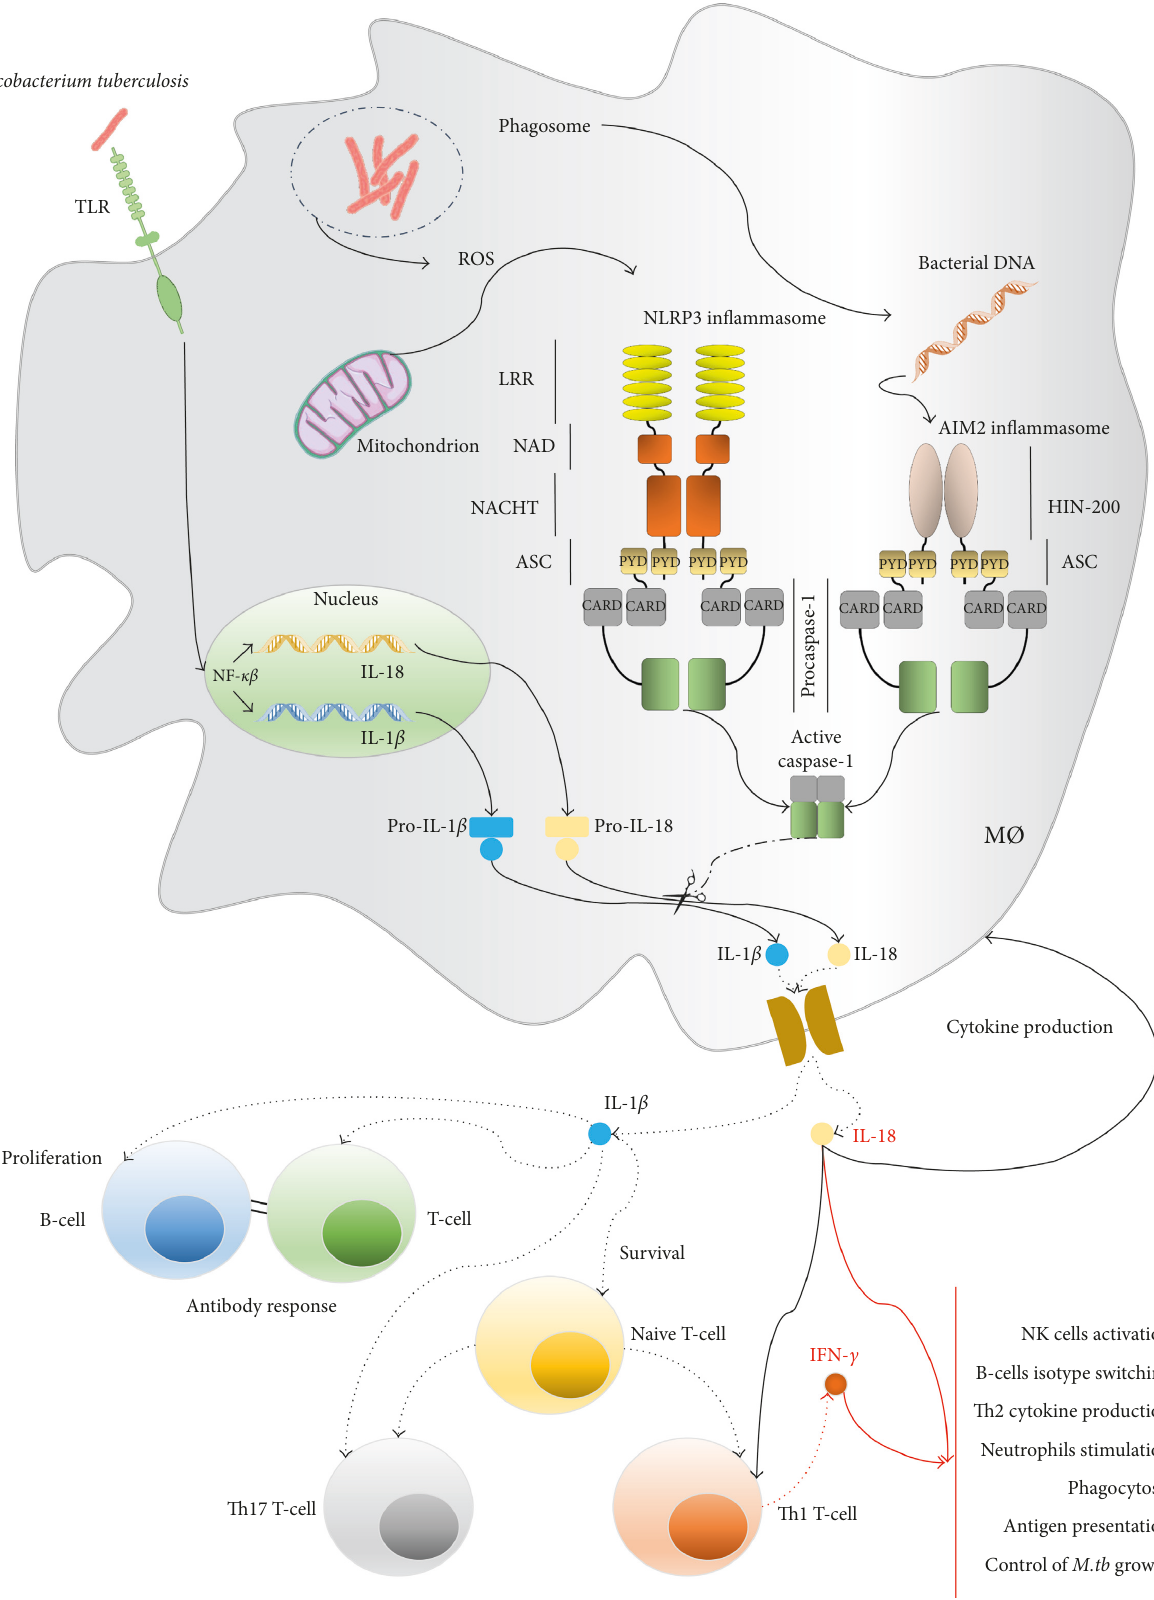
Figure 1: AIM2 and NLRP3 inflammasome activation pathways induced by Mycobacterium tuberculosis